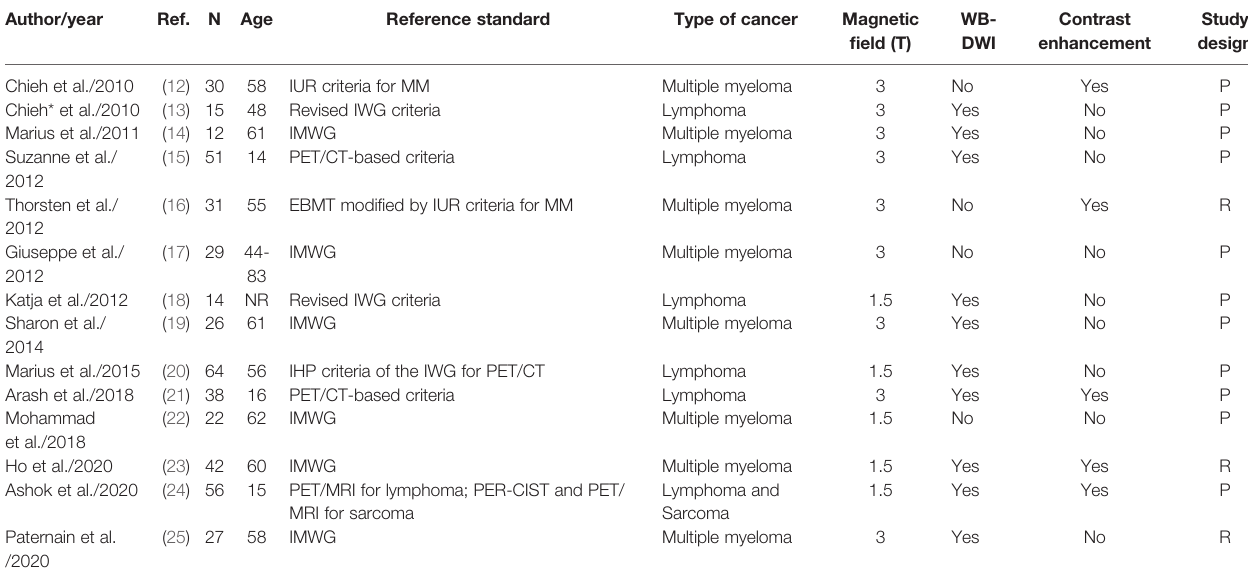
TABLE 1 | Basic characteristics of the included